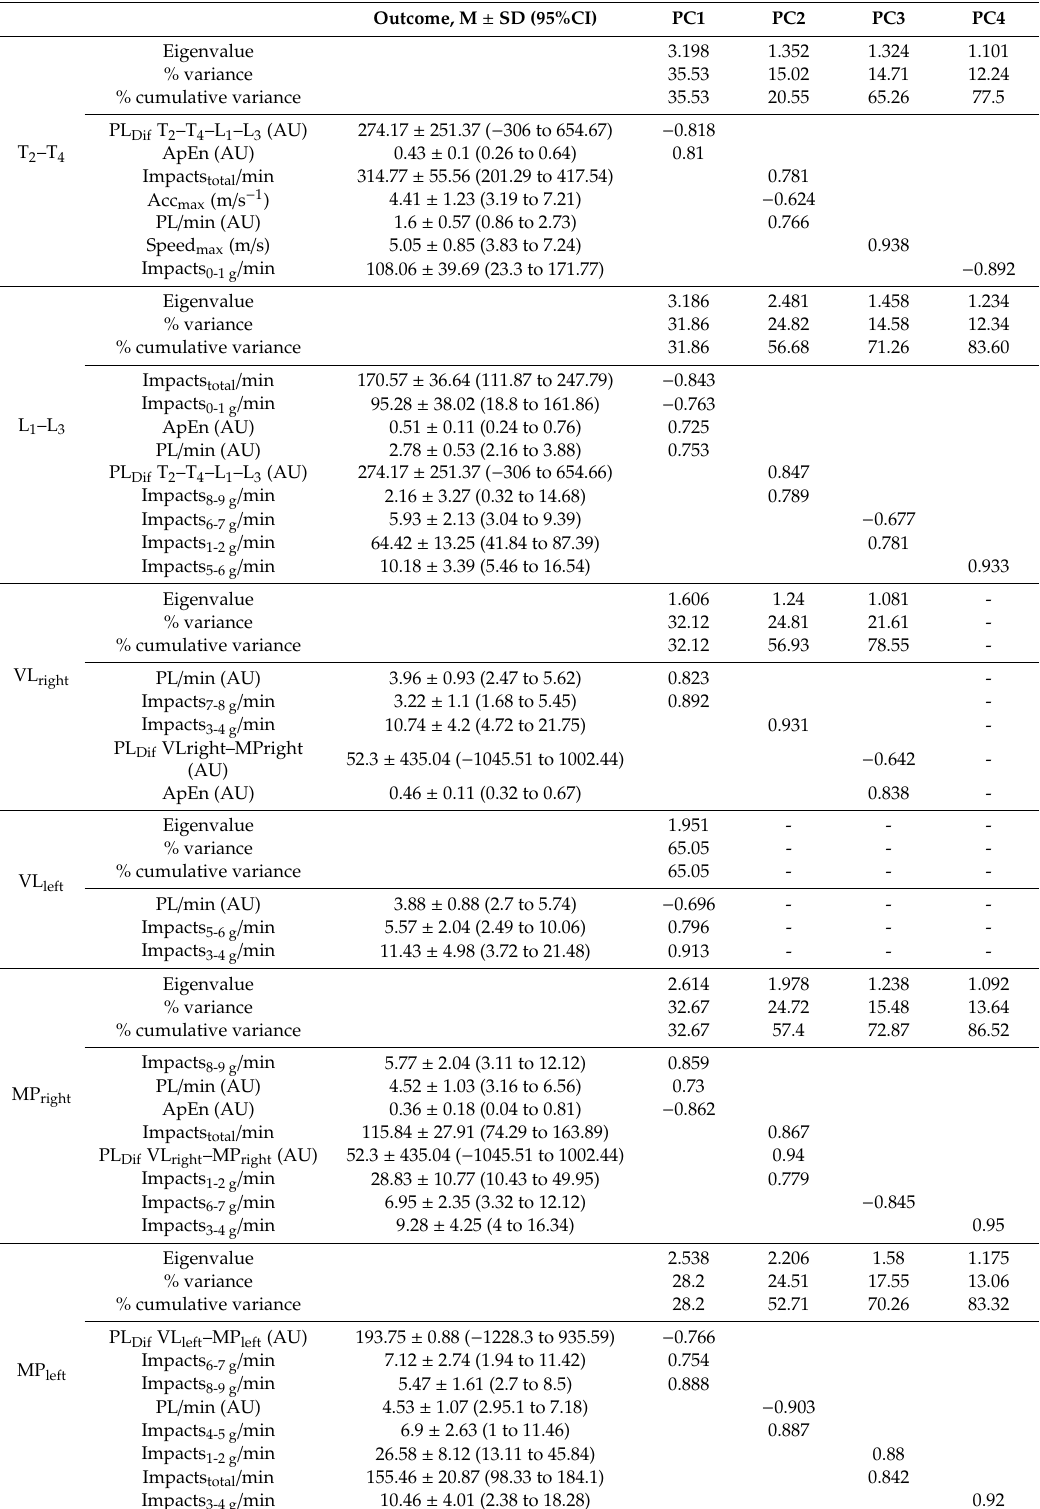
Table 2. External workload variables outcome and extracted principal components of each body segment